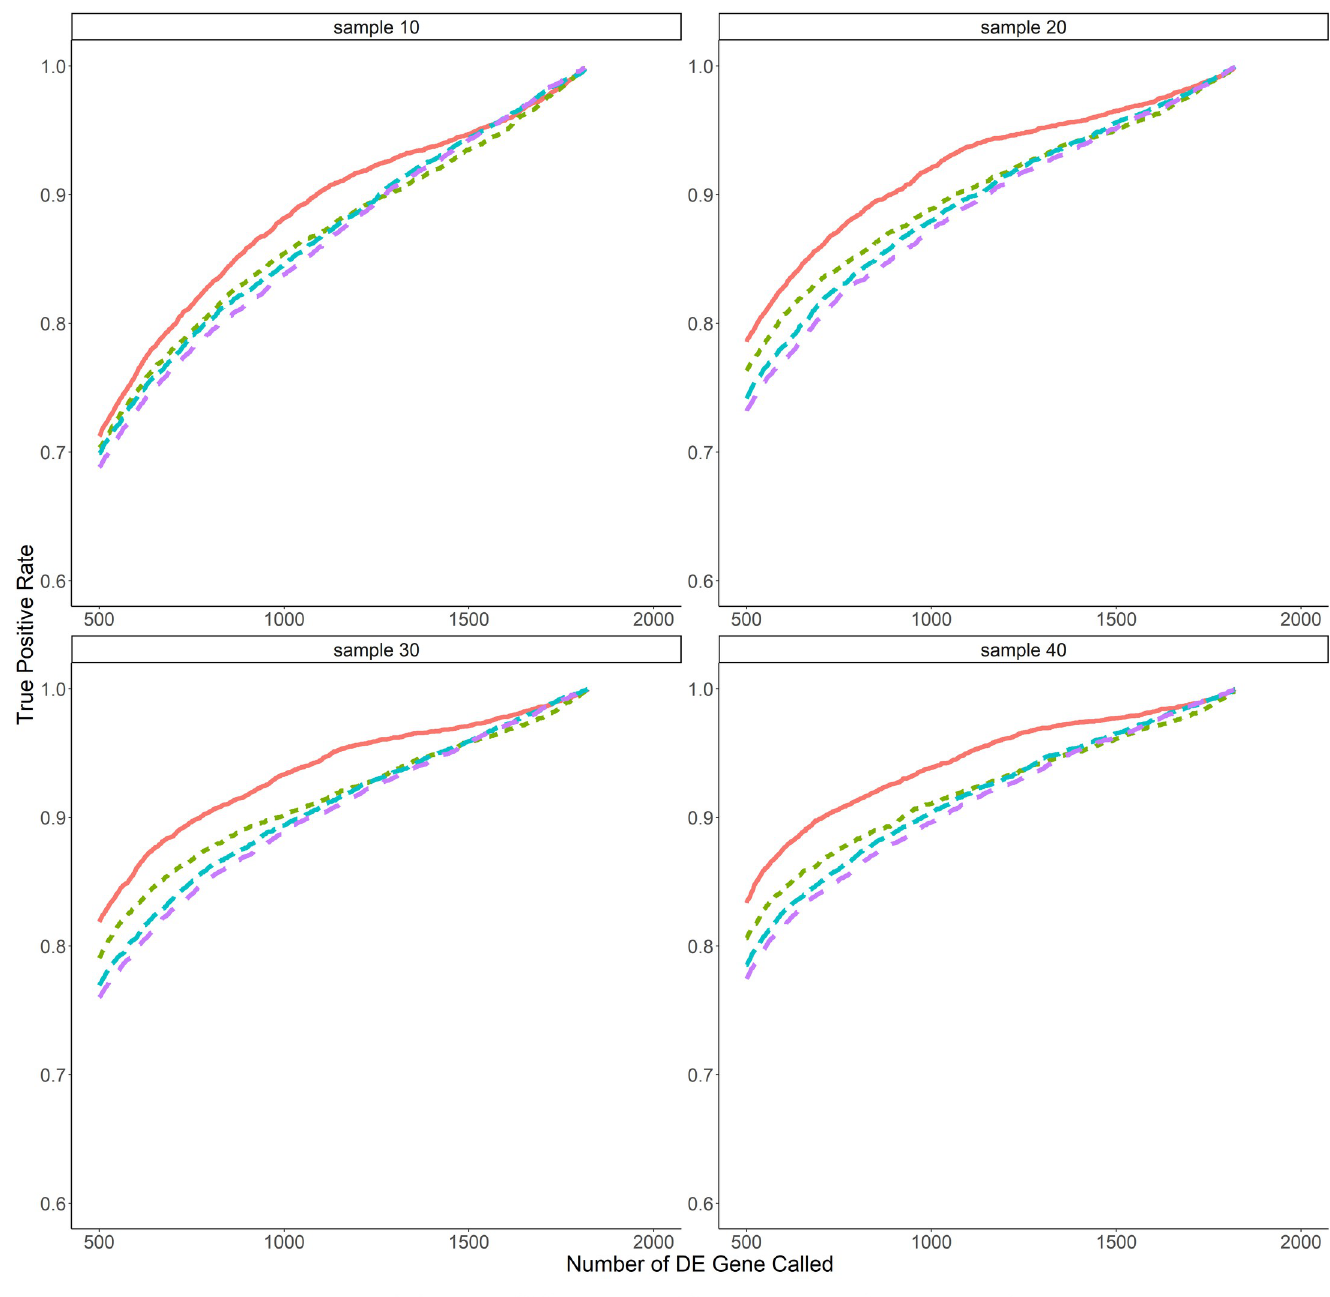
Fig 9. True positive rate vs. number of DE gene called with large